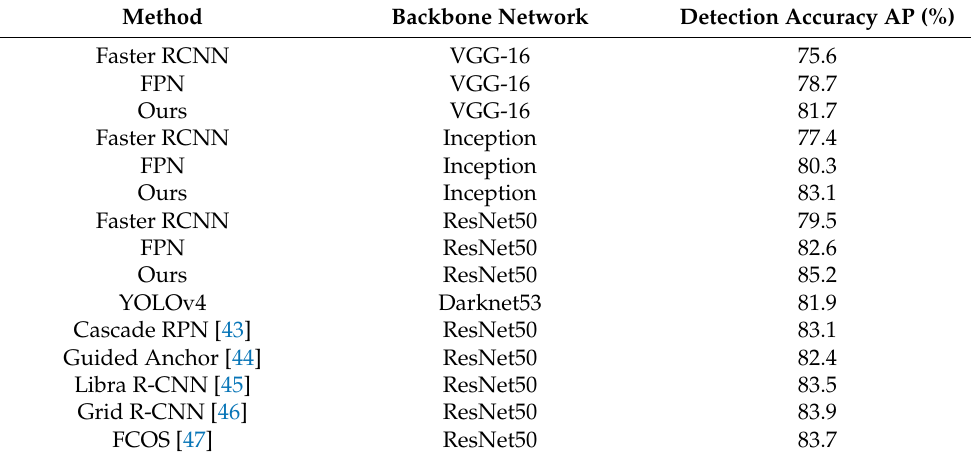
Table 3. Performance comparison of the different detection